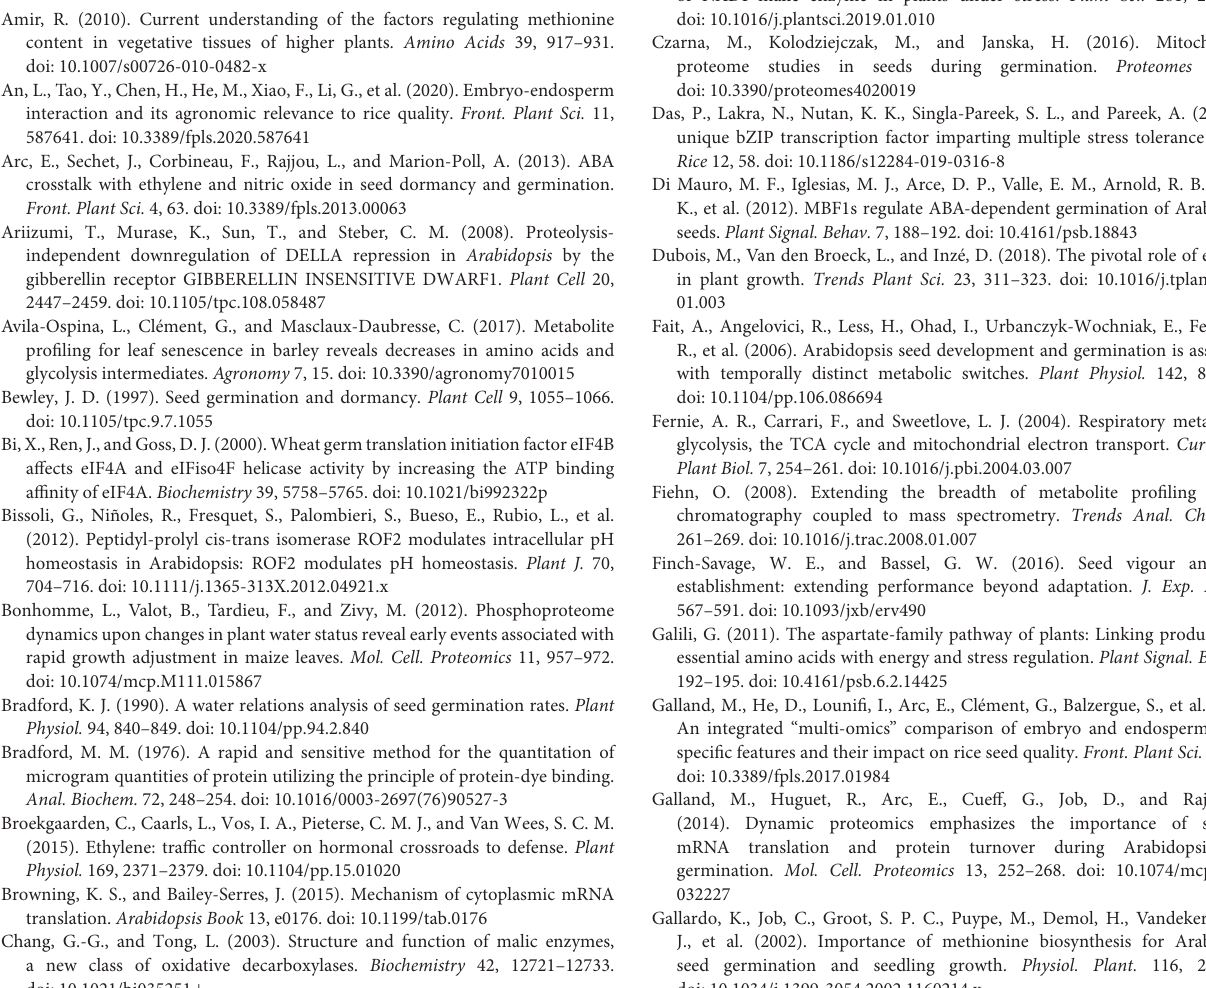
Supplementary Table S5G | The 109 significantly down-accumulated proteins in germinated rice endosperm. Selection criteria: p < 0.05, log 2 ratio_A24vsA0 <